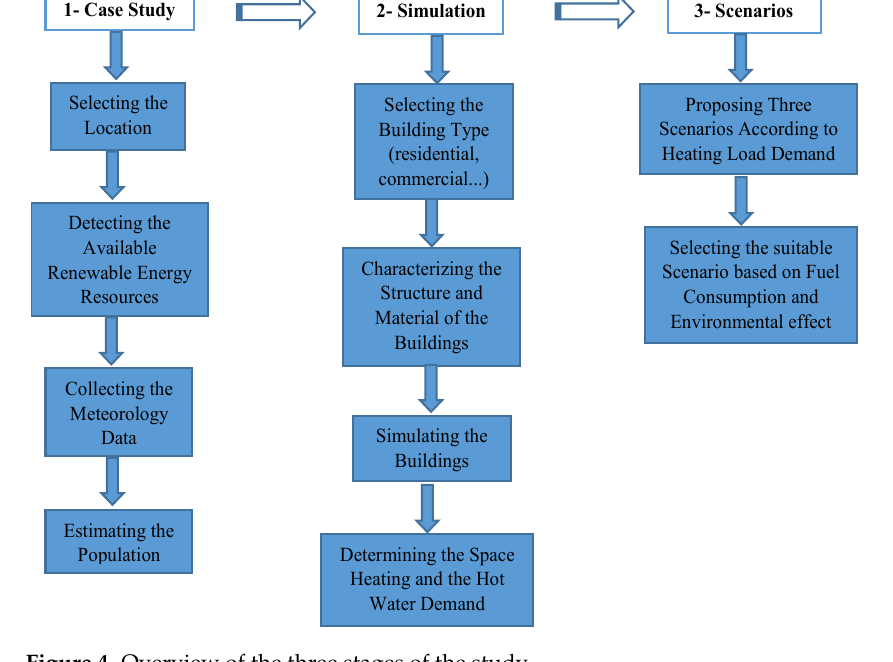
Figure 4. Overview of the three stages of the study.